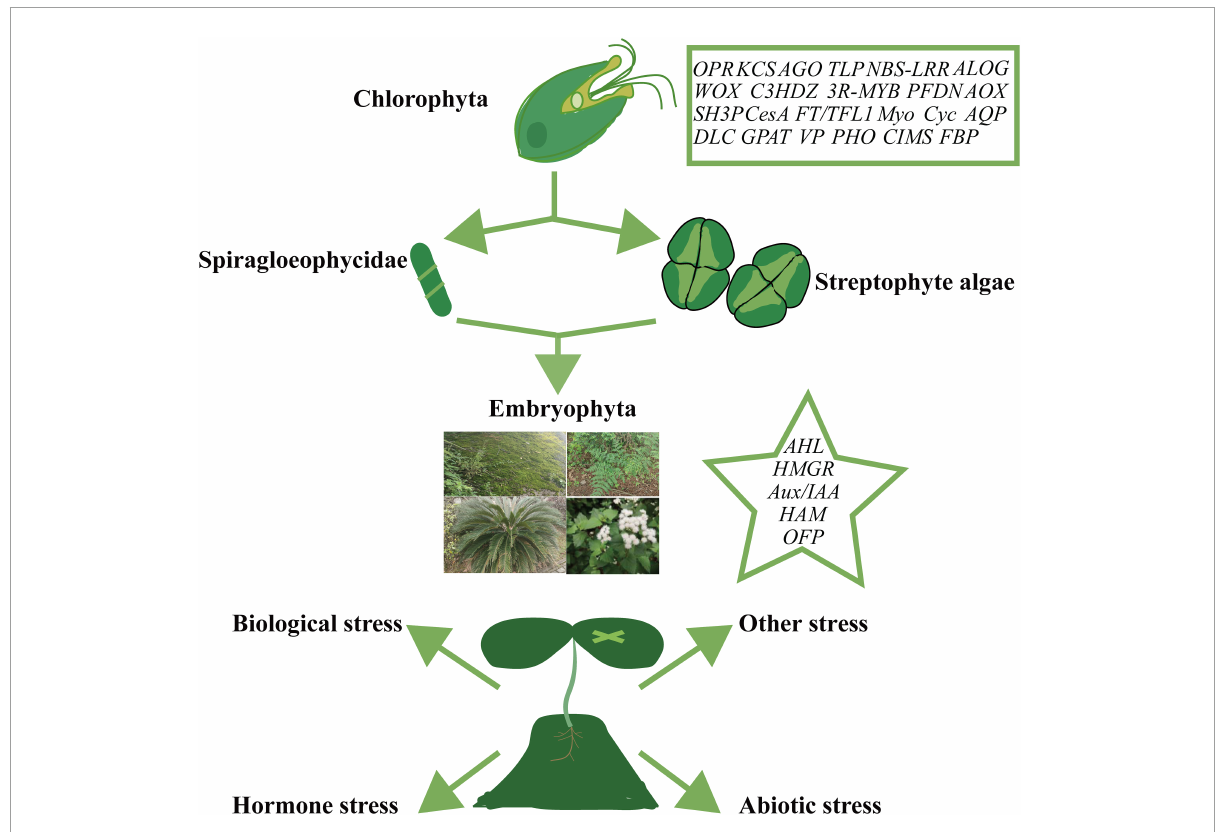
FIGURE3 Origin and expansion of plant gene families. Gene families in boxes representing their origin in green algae or earlier. Families include OPR (12-oxo-phytodienoate acid reductase), KCS (3-ketoacyl-coa synthase), AGO (Argonaute), TLP (thaumatin-like protein), NBS-LRR (nucleotide binding site leucine-rich repeat), ALOG (Arabidopsis LSH1 and Oryza G1), WOX (WUSCHEL-related), C3HDZ (class III homeodomain-zinc finger protein), 3R-MYB, PFDN (prefoldin), AOX (alternative oxidase), SH3P (SH3 and BAR domain-containing protein), CesA (cellulose synthase), FT/TFL1 (flowering locus t/terminal flower 1), Myo (myosin), Cyc (cyclin), AQP (aquaporins), DLC (dynein light chain), GPAT (glycerol-3-phosphate acyltransferase), VP (vacuolar-type H+-pyrophosphatase), PHO (phosphate 1), CIMS (cobalamin-independent methionine synthase), and FBP (F-box). Gene families listed in the star may have contributed to the development of Streptophyte algae or functional innovations in the plant community, and include AHL (AT-hook motif nuclear localized), HMGR (3-hydroxy-3-methylglutaryl coenzyme A reductase), Aux/IAA (auxin/indole acetic acid and auxin response factor), HAM (hairy meristem), and OFP (OVATE family